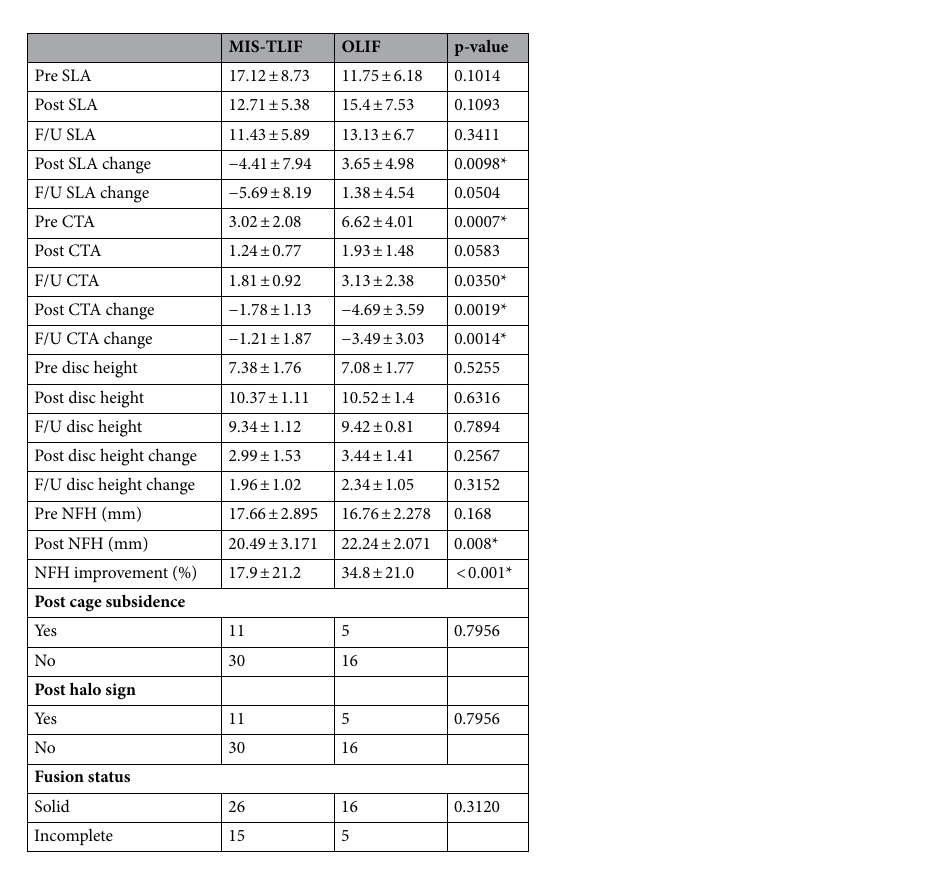
Table 3. Radiographic outcomes. Values are mean ± standard deviation; SLA: segmental lordotic angle; CTA: coronal tilting angle; Post: post-operative (3 days after surgery); F/U: final follow-up (24 months after surgery); NFH: neuroforaminal height. *p < 0.05, statistical